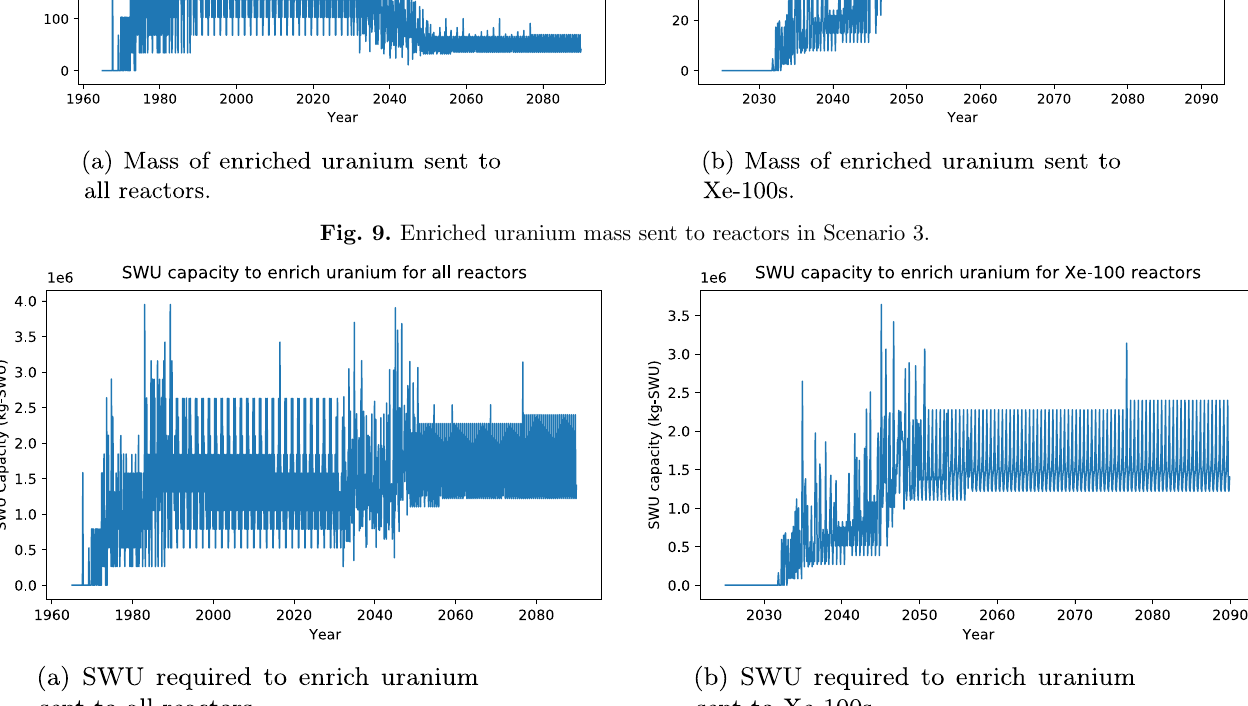
Fig. 10. SWU required to enrich natural uranium in Scenario